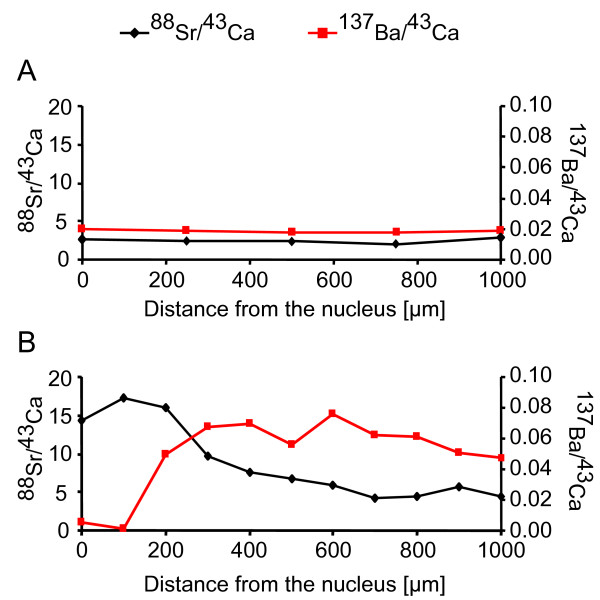
Typical patterns of 88Sr and 137Ba counts normalised to 43Ca in otolith cross sections from the nucleus to the edge. A: non-diadromous profile (category A) in a female Gobiomorphus cotidianus (92 mm) from the Kaituna River. B: diadromous profile (category B) in a male G. cotidianus (96 mm) from the downstream Tarawera River.